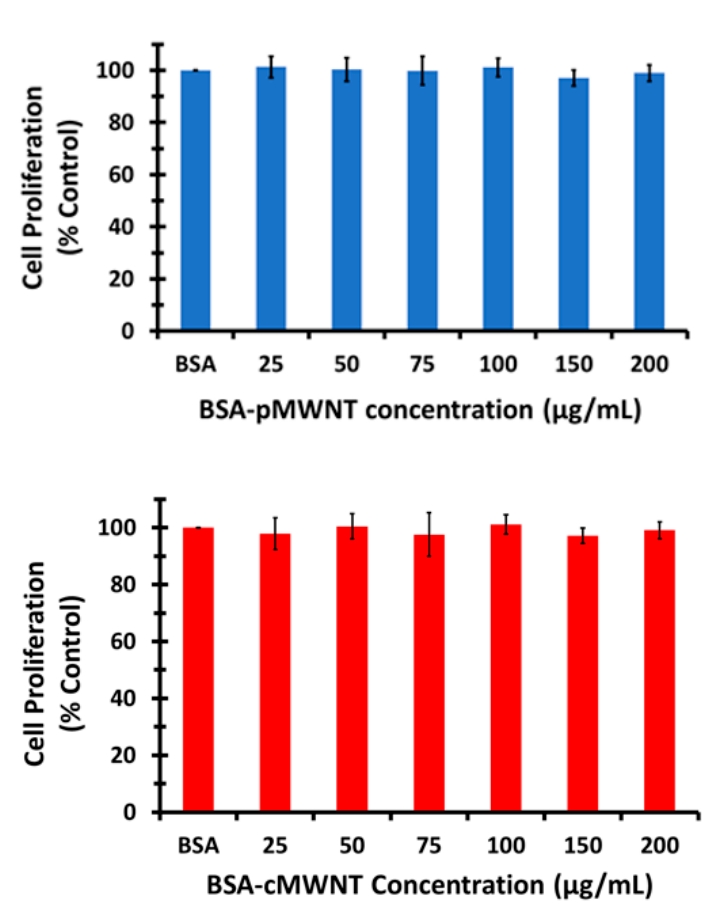
Figure 1. Cell proliferation of RAW 264.7 cells cultured with BSA-MWNTs. MWNTs suspended in a 0.10 mg/mL BSA working solution were mixed with an equal volume of 2X-concentrated medium to produce MWNT concentrations shown on the x-axes of the graphs. An equivalent number of cells were seeded in 48-well plates and incubated at 37 ◦ C under standard cell culture conditions for 24 h prior to the experiment. Cell proliferation after incubation with control and test media for 24 h at 37 ◦ C was determined by the crystal violet assay as described in the Methods, where the proliferation of control cells exposed to BSA in the absence of MWNTs was set to 100%. ( Top ) RAW 264.7 macrophage cell proliferation post 24-h incubation with various concentrations of BSA-pMWNTs. ( Bottom ) RAW 264.7 macrophage cell proliferation post 24-h incubation with various concentrations of BSA-cMWNTs. Both data sets are the mean of quadruple samples in three independent experiments ± the standard deviation